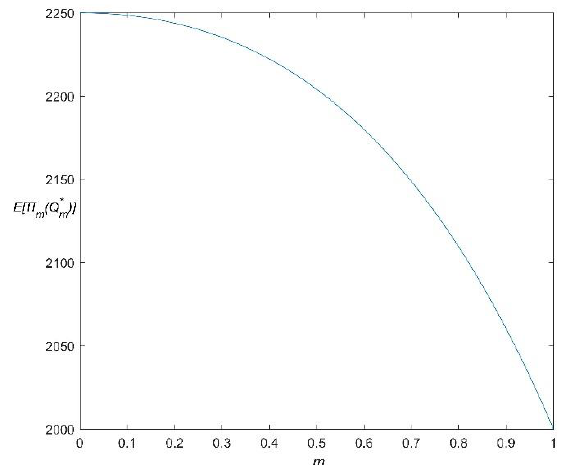
Figure 4. Expected profits E [ ∏ m ( Q ∗ m )] under different fixed-term contracts supplier default rate m .